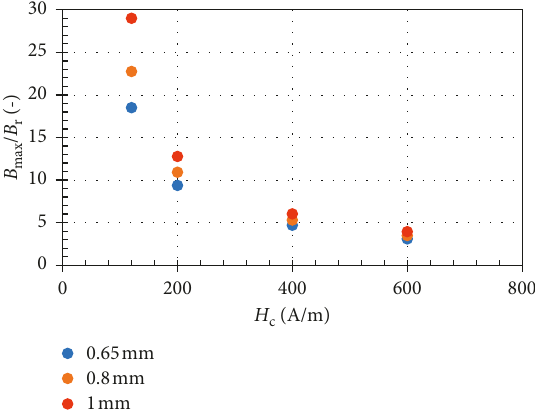
Figure 23: Remanent flux density variation with coercivity and gap size.